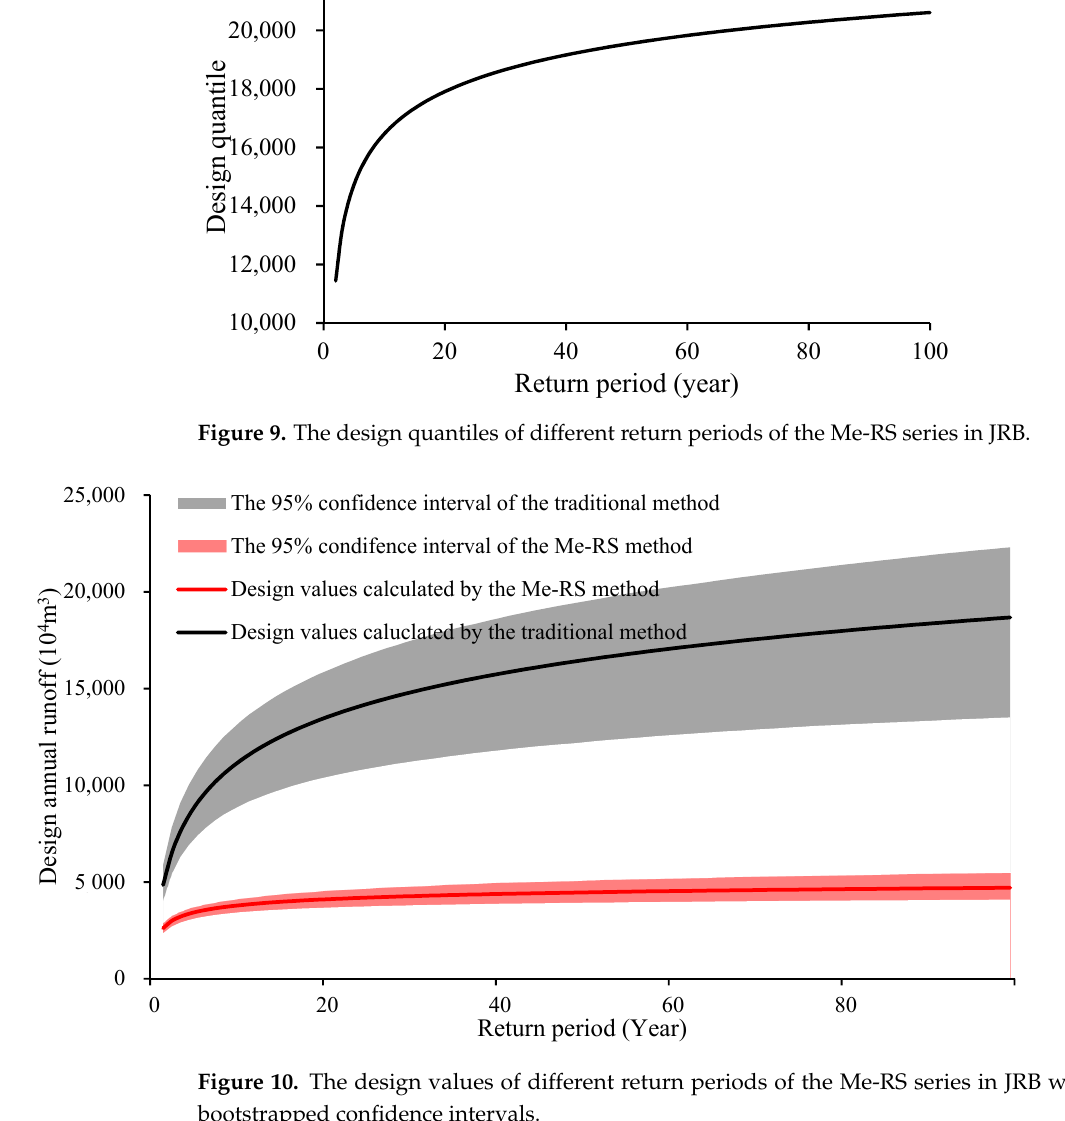
Figure 9. The design quantiles of different return periods of the Me-RS series in JRB.